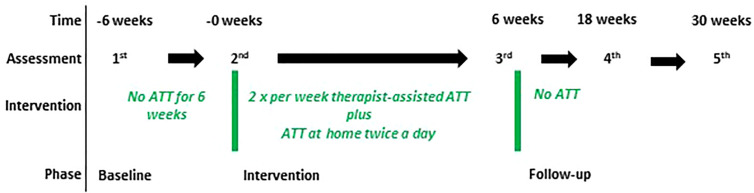
Study design. The figure shows the design of the case series. Patients (n=3) were assessed using the Yale Global Tic Severity Scale (YGTSS), Gilles de la Tourette syndrome-quality of life scale (GTS-QoL), Rush Modified Video-Based Rating Scale, Premonitory Urge for Tics Scale (PUTS), Metacognitions Questionnaire (MCQ30), and Thinking about Tic (THAT) at each assessment. During the study medication was unchanged. ATT started after baseline (0 weeks). After the intervention (6 weeks), patients discontinued ATT and were again assessed 18 and 30 weeks after the start of the intervention as follow-up.